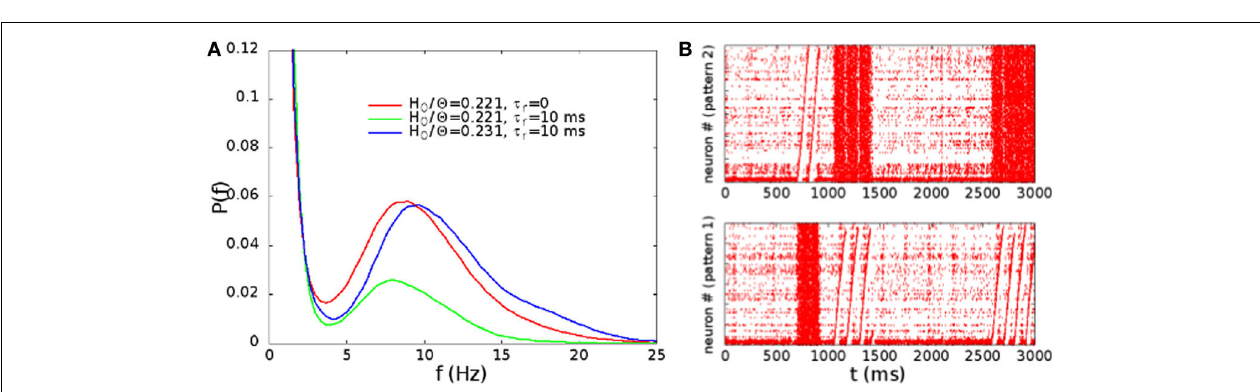
FIGURE 9 | (A) Distribution of the rates, evaluated as in Figure 3 , in absence of STSD for H 0 /(cid:4) = 0 . 221 (point B in Figure 2 ), and in presence of STSD for H 0 /(cid:4) = 0 . 221 and 0 . 231. (B) Raster plot